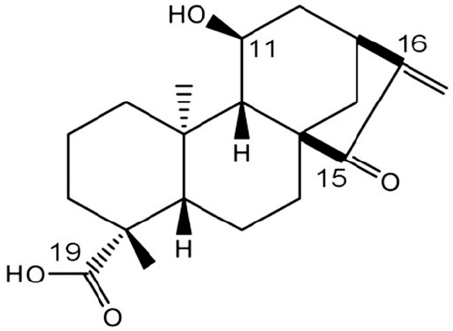
Figure 1. The structure of ent -11 α -hydroxy-15-oxo-kaur-16-en-19-oic acid (11 α OH-KA).